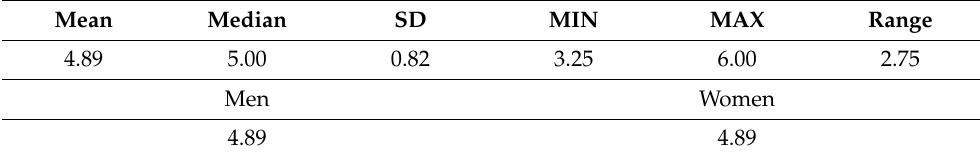
Table 3. Mean, median, standard deviation, minimum, maximum, and range of the selection process.